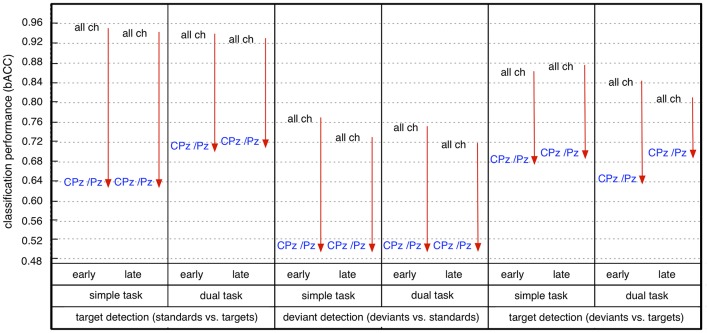
Effect of reduction of channel number on classification performance (early: early window, late: late window, all ch: all 62 channels, CPz/Pz: 2 parietal channels). Arrow direction refers to significant increases or decreases. Lines without arrow direction refer to no significant difference. Statistical values for comparison are reported in Supplementary Materials in Figure S4 (comparison between all 62 channels (all Ch) and 2 parietal channels (CPz/Pz) in Figure S4).